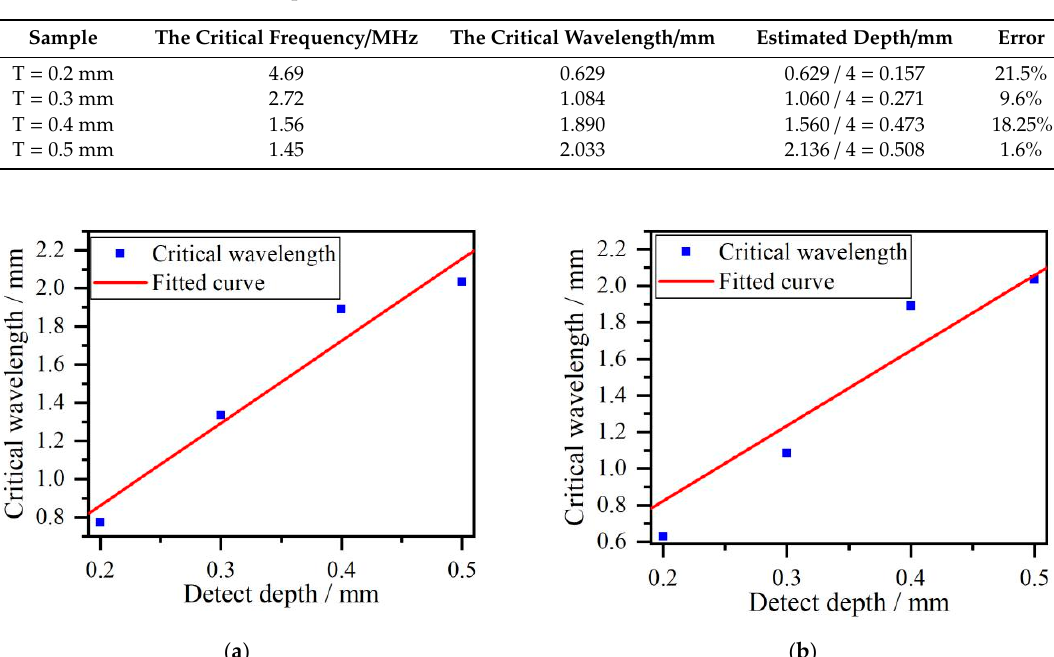
Table 4. Estimated crack depth and relative error for simulation element with the maximum size 0.5 mm.